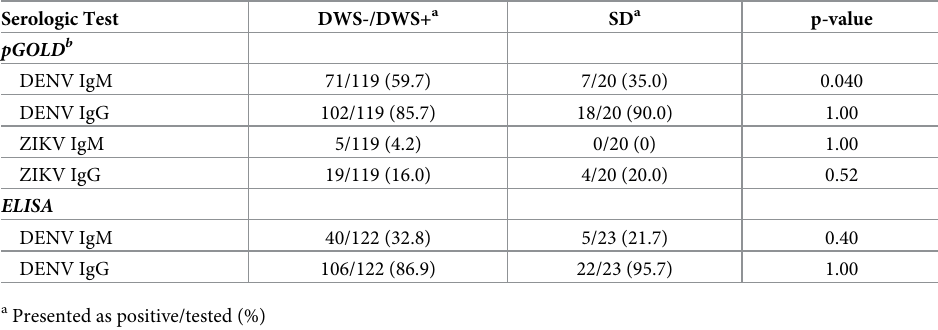
Table 3. Serologic test results stratified by disease